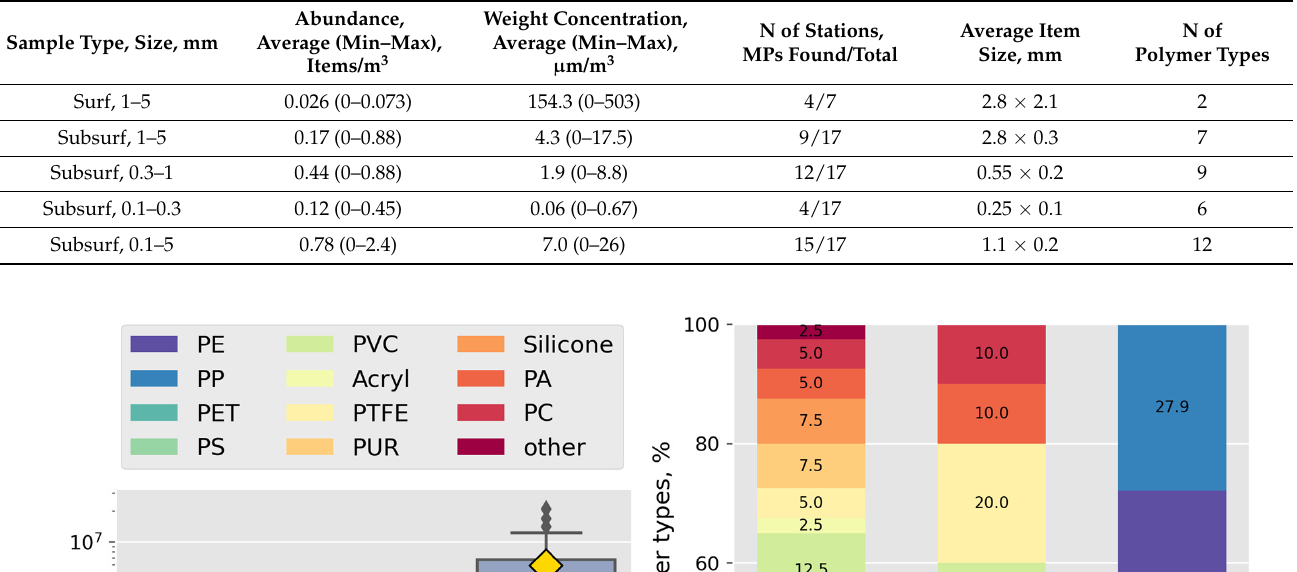
Figure 3. Surface square ( left ) and polymer composition ( right ) of found microplastics (“square” refers to the surface area of a particle).